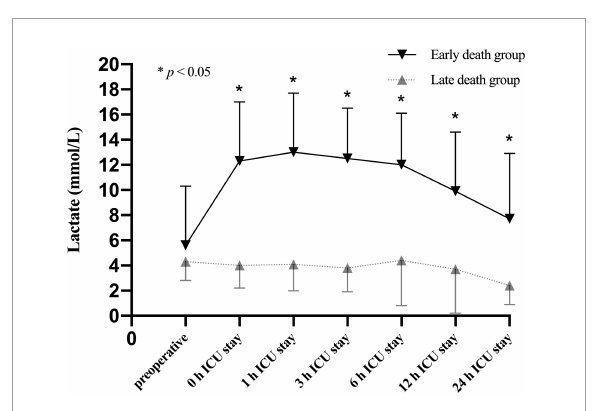
FIGURE5 Lactate levels (mean and standard deviation) of patients stratified with the time distribution of death in the non-survivors of CRRT group at multiple time points.